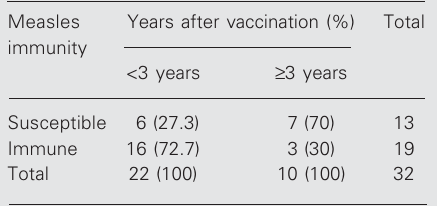
Table 2. Long-term immunity after measles vacci- nation in bone marrow transplant recipients.